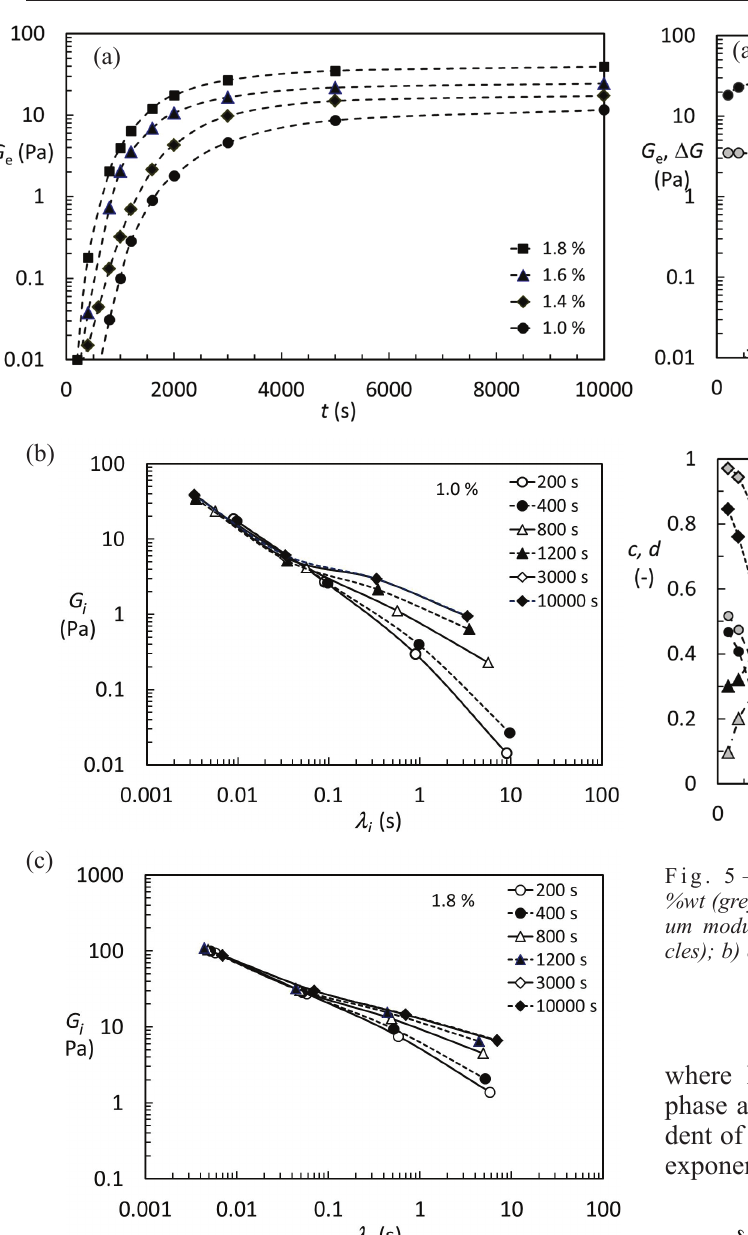
Fig. 4 – Time evolution of the gM parameters. a) Equilibri- um modulus G vs process time at different CMCA concentra- e tions (1.0 %wt (circles), 1.4 %wt (diamonds), 1.6 %wt (trian- gles), 1.8 %wt (squares); b) time relaxation spectra of systems 1.0 %wt at different process times (in seconds): 200 (orange), 400 (red), 800 (fuchsia), 1200 (violet), 3000 (light blue), 10000 (dark blue); c) time relaxation spectra of systems 1.8 %wt at different process times (in seconds): 200 (orange), 400 (red), 800 (fuchsia), 1200 (violet), 3000 (light blue), 10000 (dark blue).